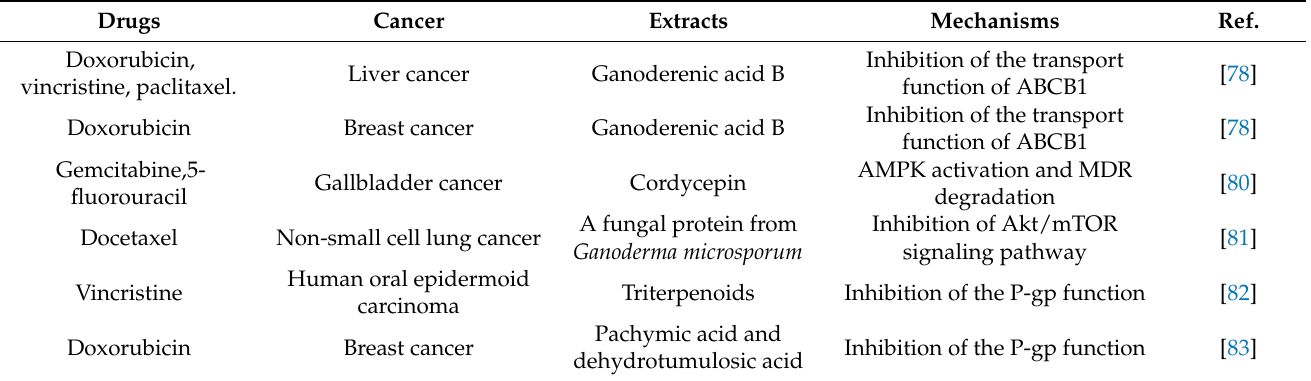
Table 2. Summary of extracts from edible and medicinal fungi in combination with chemotherapeutic